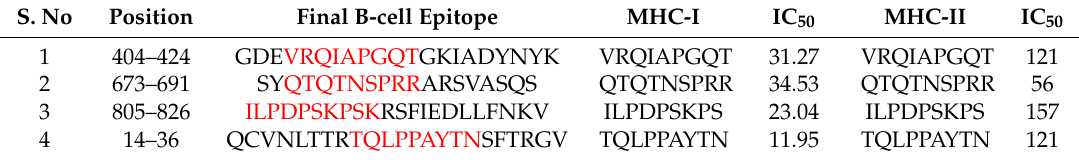
Table 1. Overlapped (Red) epitope of B-cell, MHC-I, and MHC-II with IC 50